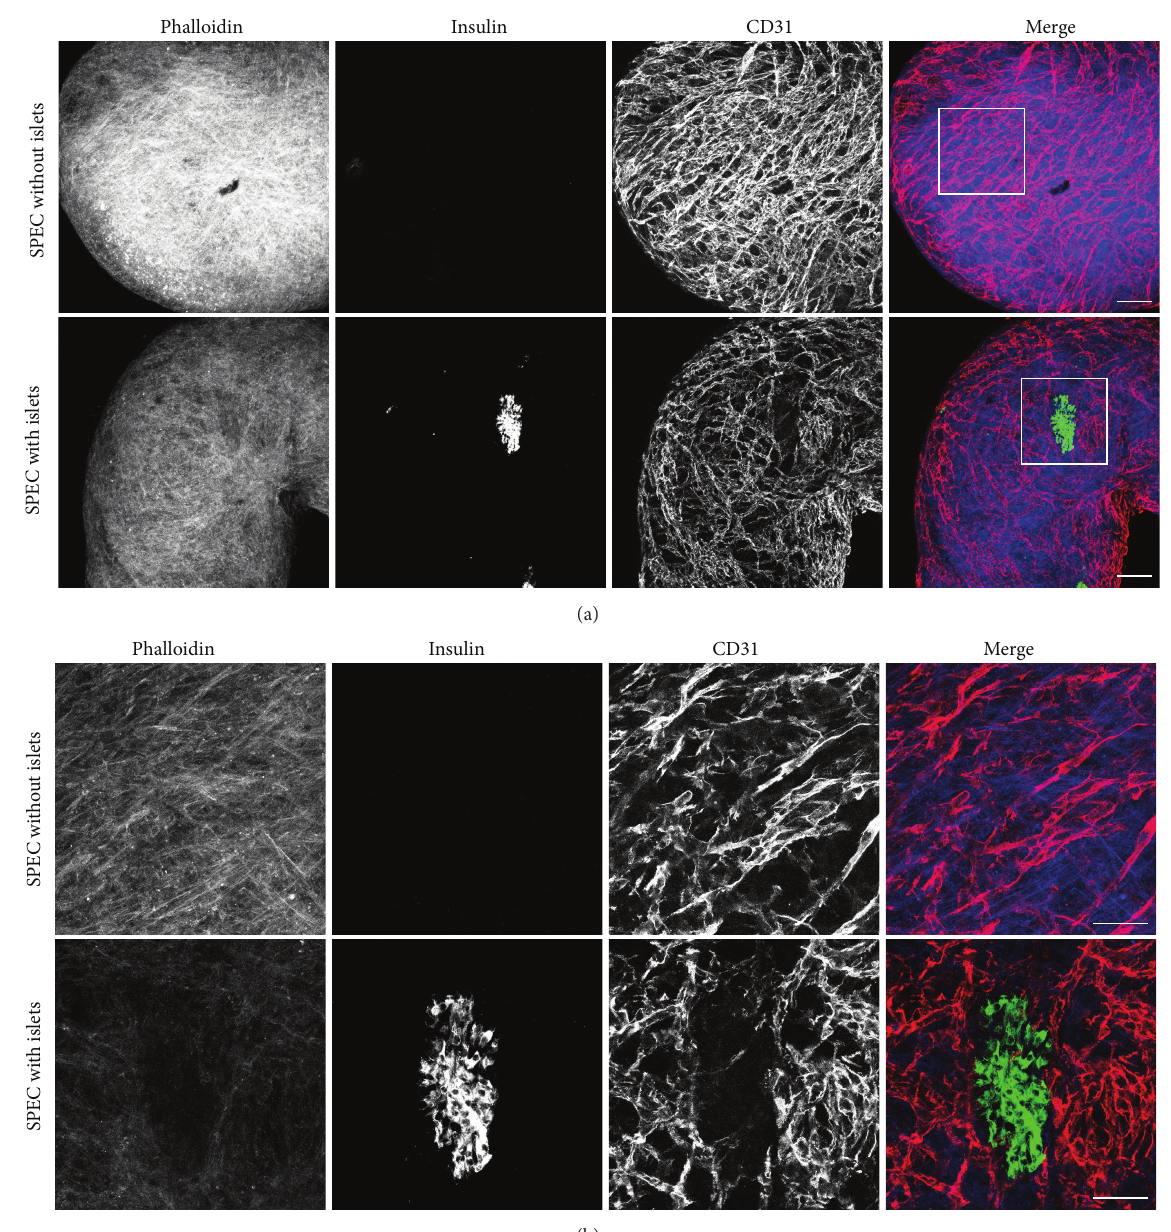
Figure 1: Incorporation of islets into SPECs does not affect vascular network formation. SPECs with and without islets were generated, fixed, and whole-mount-labeled for actin (phalloidin, blue), islets (insulin, green), and endothelial cells (CD31, red). The images are maximum projections of z-stacks acquired by confocal microscopy under 20x magnification (a) and 63x magnification [(b), boxed regions in (a)]. Note the dense, web-like pattern of endothelial cells in both constructs, indicating a robust vascular network. Importantly, the vascular network surrounds the embedded islet. Scale bars represent 100 𝜇 m and 50 𝜇 m in (a) and (b),